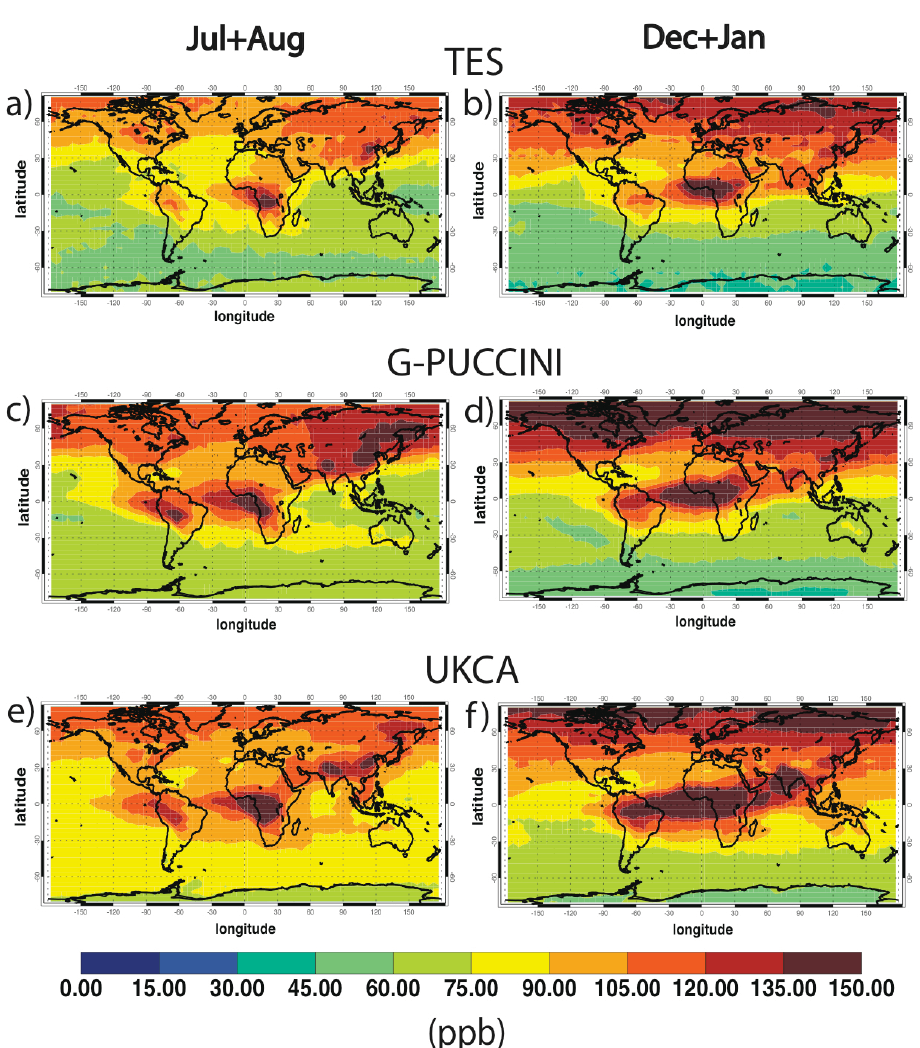
Fig. 1. Mean 2005–08 middle/lower free tropospheric CO concentrations for TES (a, b) , G-PUCCINI (c, d) and UKCA (e, f) in July–August (left panels) and December–January (right panels). We used data from 7 TES pressure levels between 800 and 400hPa. TES sampling and operators have been applied to the model output. The data have been smoothed by averaging on a 4 × 5 degree